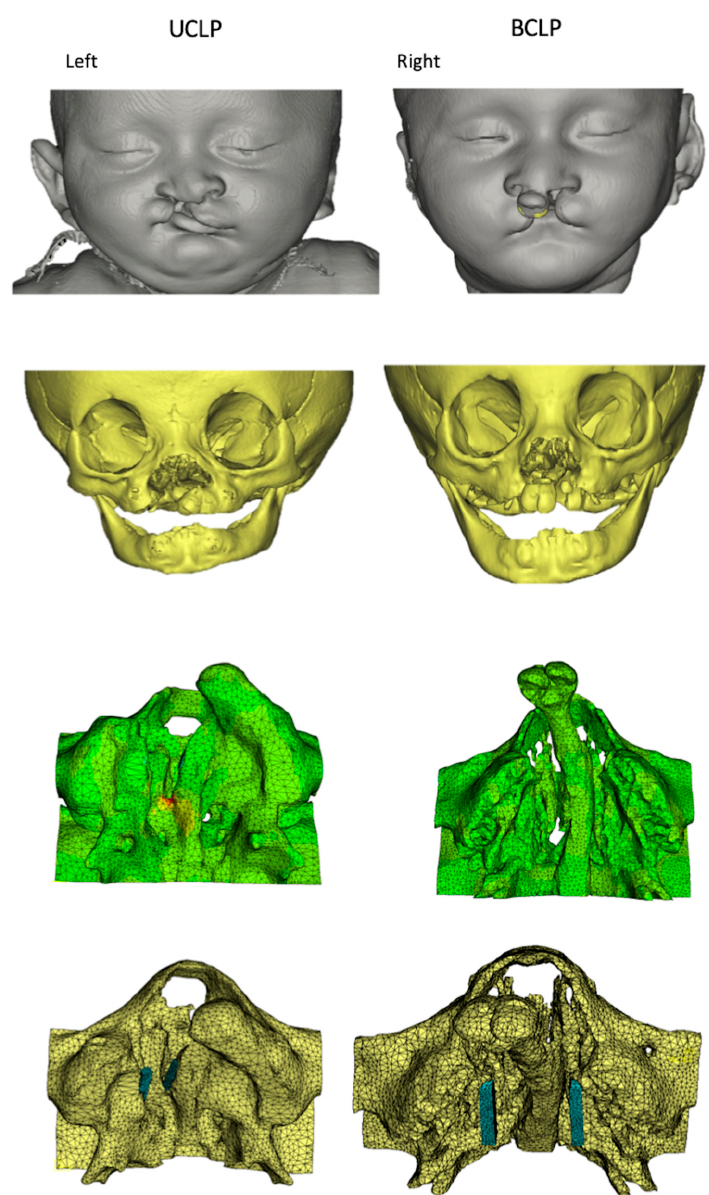
Figure 1. From computed tomography scans to finite element (FE) models with magnets in the unilateral cleft lip and palate (UCLP, left column) and bilateral cleft lip and palate (BCLP, right column). Frontal views of three-dimensional reconstructions of the soft tissue (first row) and hard tissue (second row). Regions of interest of the FE models (third row) and the models with magnetic strips which are blue in color (fourth row).